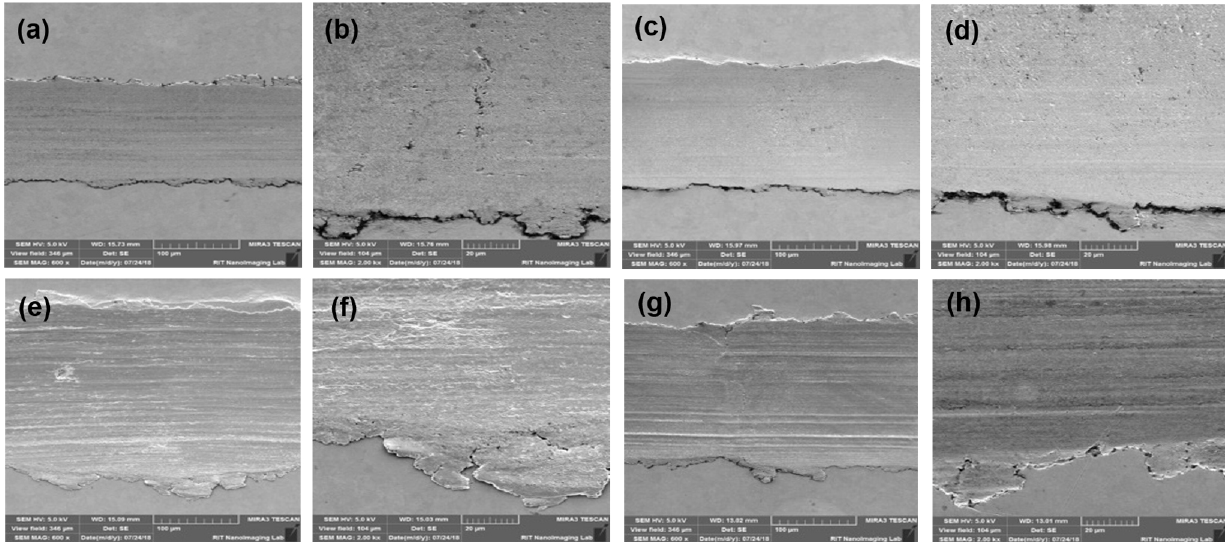
Fig. 12 SEM micrographs of wear tracks on the steel disks after a sliding distance of 200 m and lubricated with (a and b) MO at room temperature, (c and d) 1 wt% DCi+MO at room temperature, (e and f) MO at 100 ºC, (g and h) 1 wt% DCi+MO at 100 ºC. Left images display with 600× zoom and right images display with 2,000×